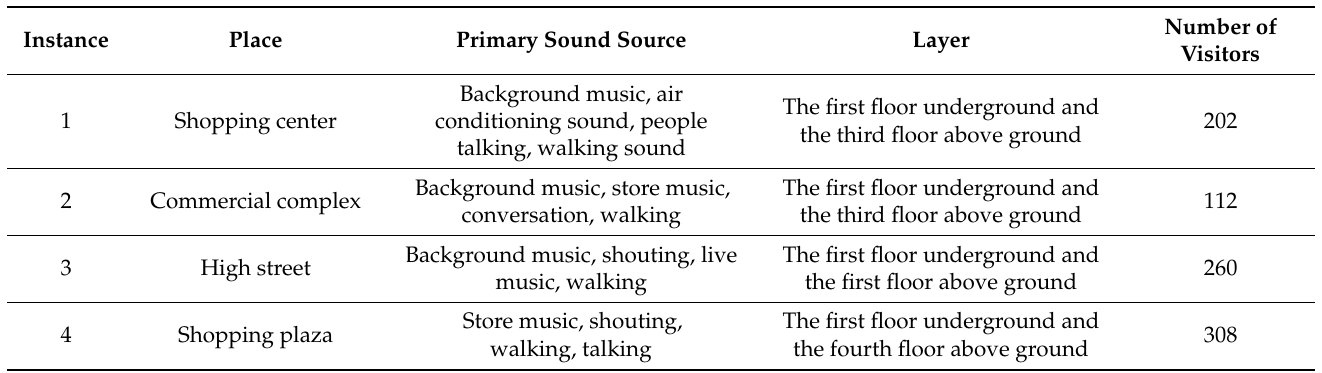
Table 2. Study cases and sound sources.